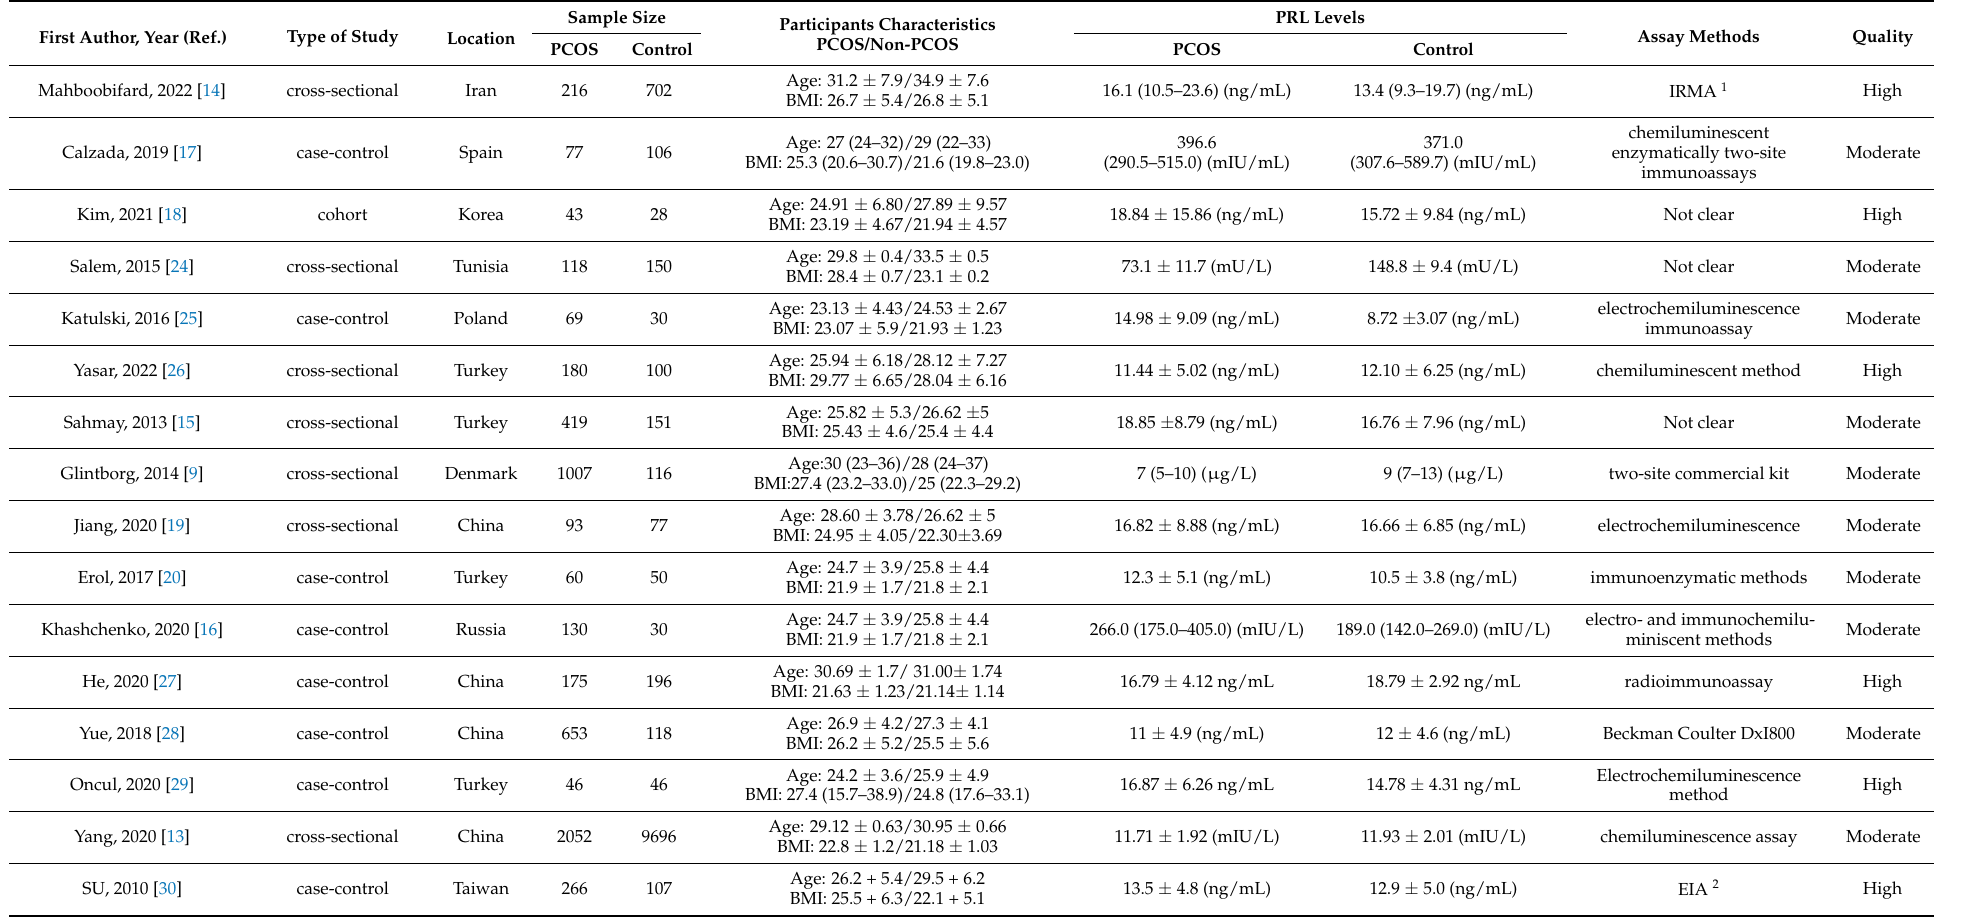
Table 1. Characteristics of included